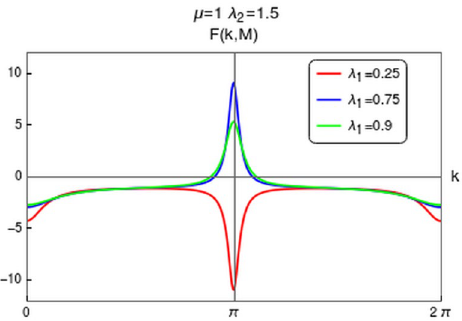
π for (cid:31) 2 > 0 . Several values of (cid:31) 1 , = 1 and (cid:31) 2 0.5 , are plotted at µ 1.5 . Curvature function shows suitable = = =